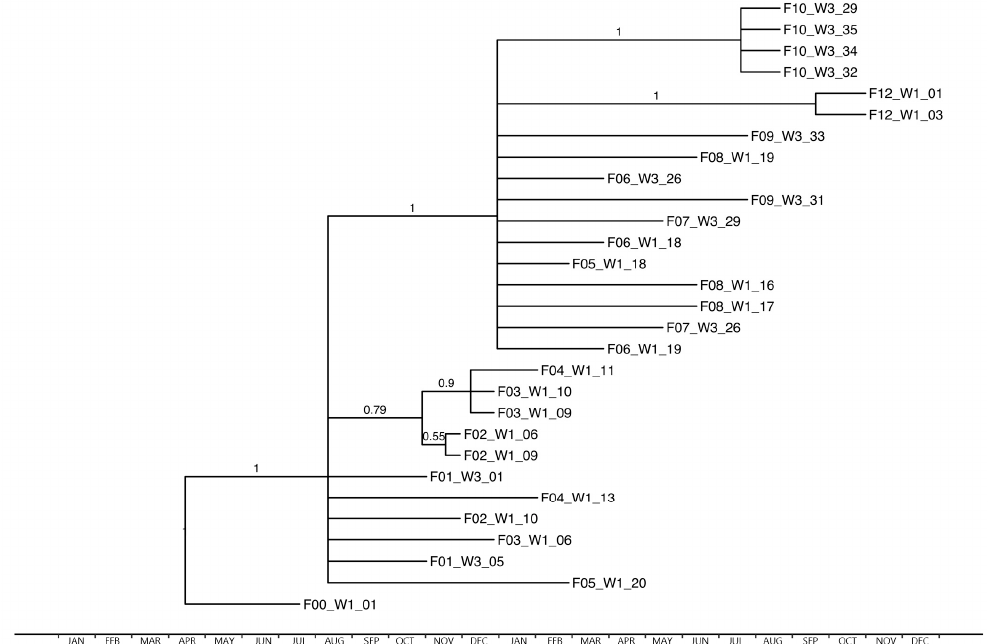
Figure 3. Bayesian strict molecular clock tree of the NA sequences. The x-axis represents time in months from 2017–2019. Branch labels represent posterior clade probabilities. F00_W1_01 sampled approx. four months before the actual study was used as an outgroup.